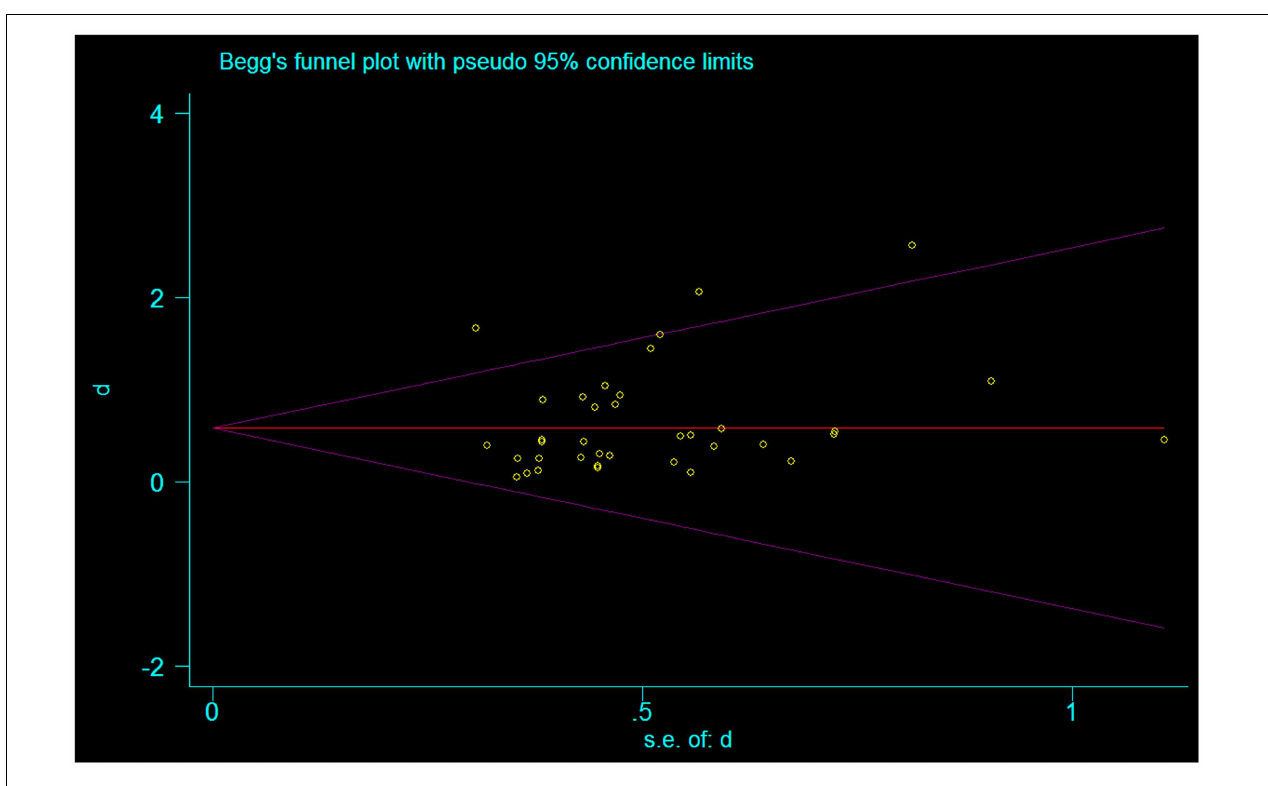
The 94% confidence interval expected for each is represented by the diagonal lines. (Of note, this graph assumes no heterogeneity between